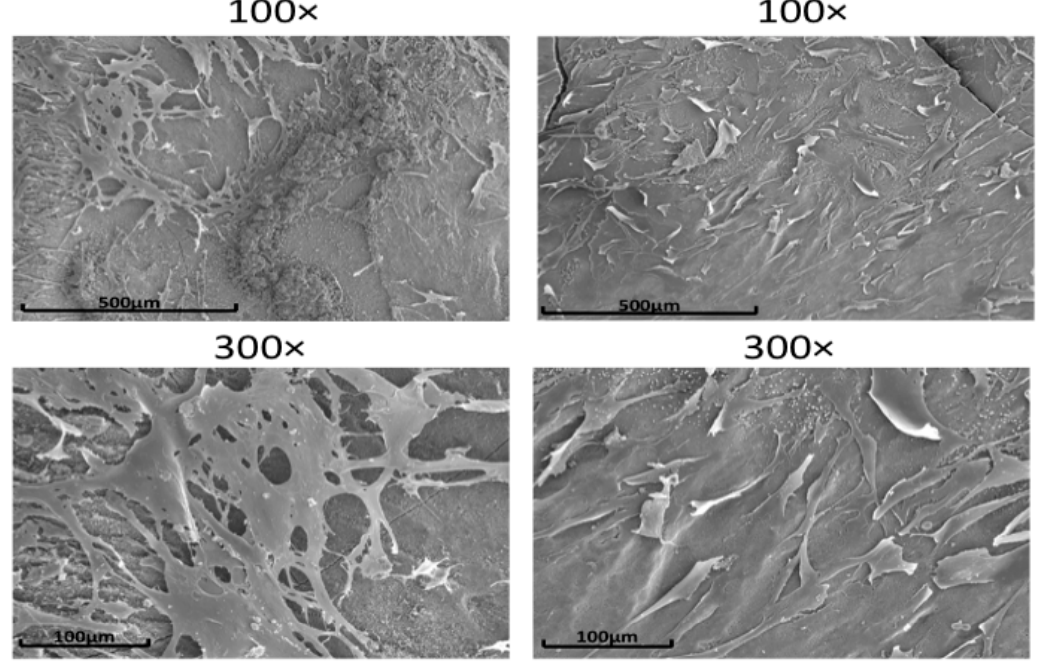
Figure 4. Cell attachment analysis. Adhesion of the stem cells from the periodontal ligament (PDLSCs) Appl. Sci. 2019 , 9 , x FOR PEER REVIEW 8 of 14 on Bio-C Repair (BCR) and TotalFill BC RRM putty (TFB) at 72 h. Scale bar: 100 µ m and 500 µ m.